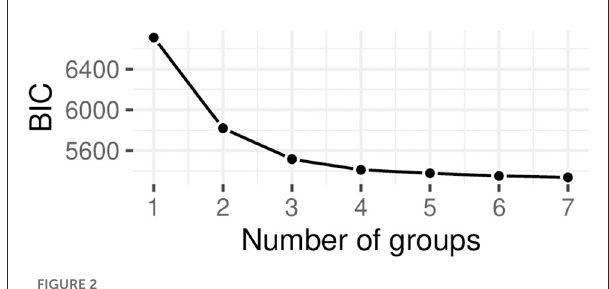
in the elbow plot in Figure 2. Entropy was slightly lower from